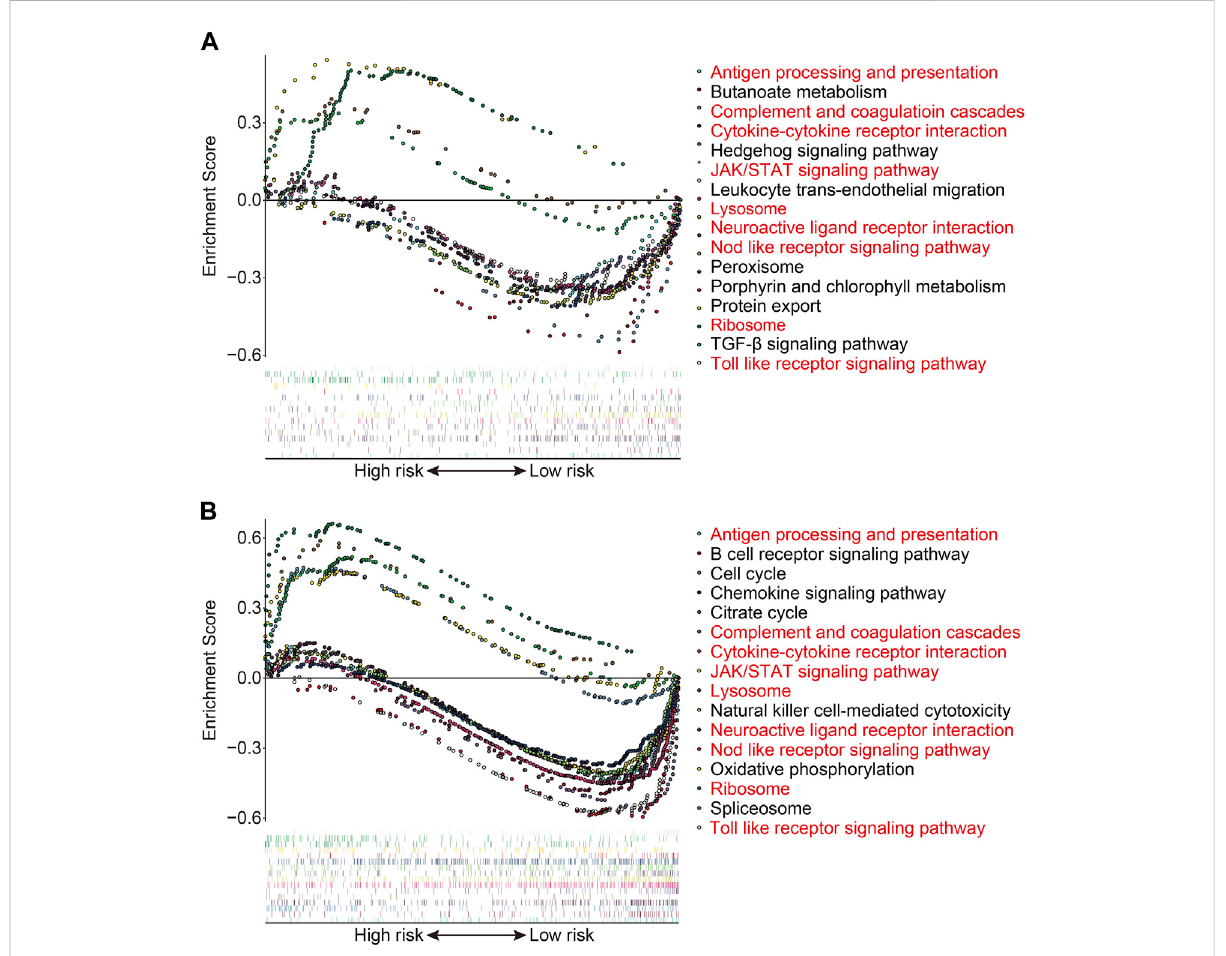
FIGURE 8 Gene set enrichment analysis between high- and low-risk groups in TCGA cohort (A) and the GSE21257 cohort (B)